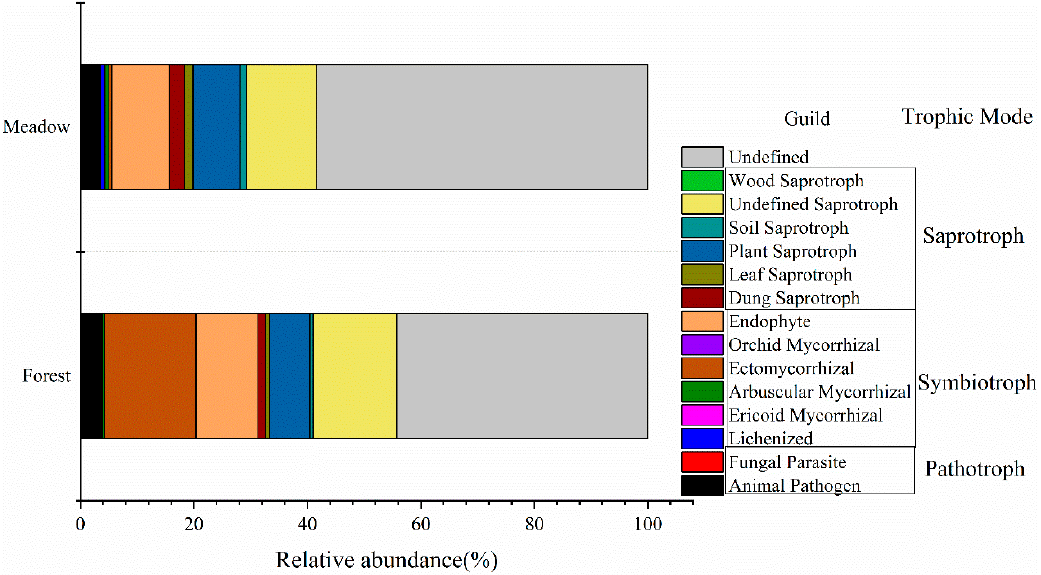
Figure 4. Comparison of the composition of fungal functional guilds inferred by FUNGuild between forest (below the treeline) and meadow (above the treeline).